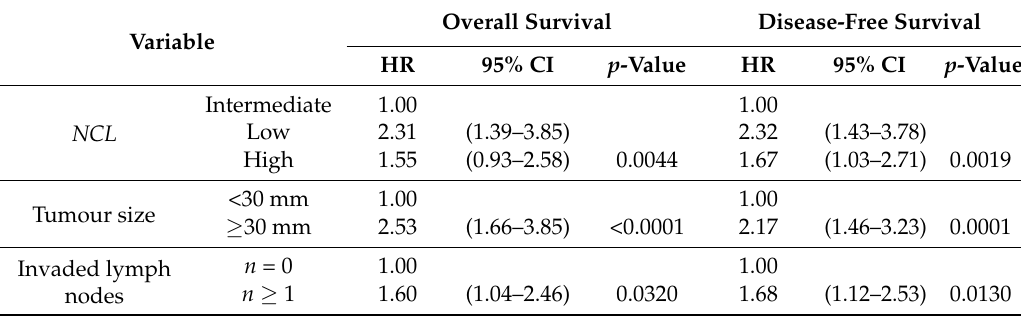
Table 2. Multivariate Cox models in Dundee